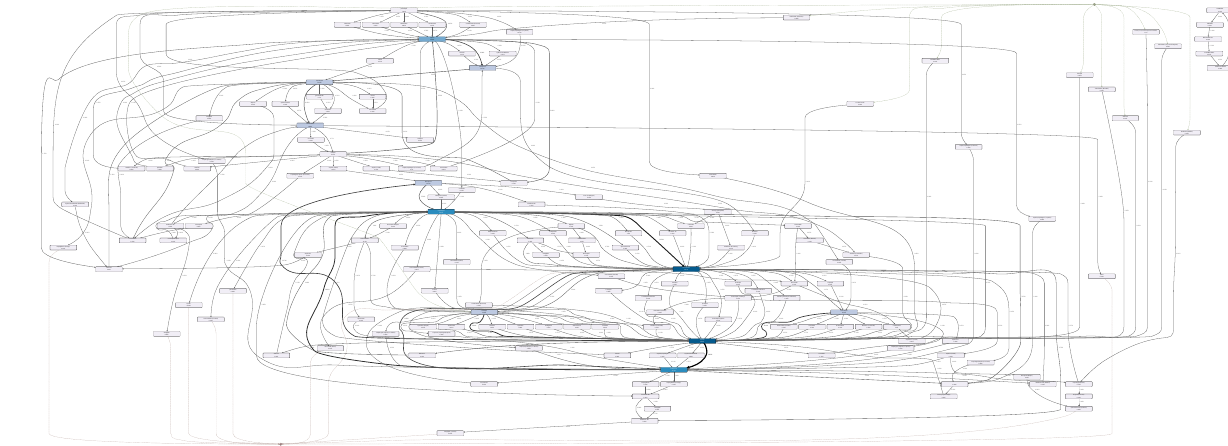
Figure 10. A snapshot of the partial process model discovered from the original event log.